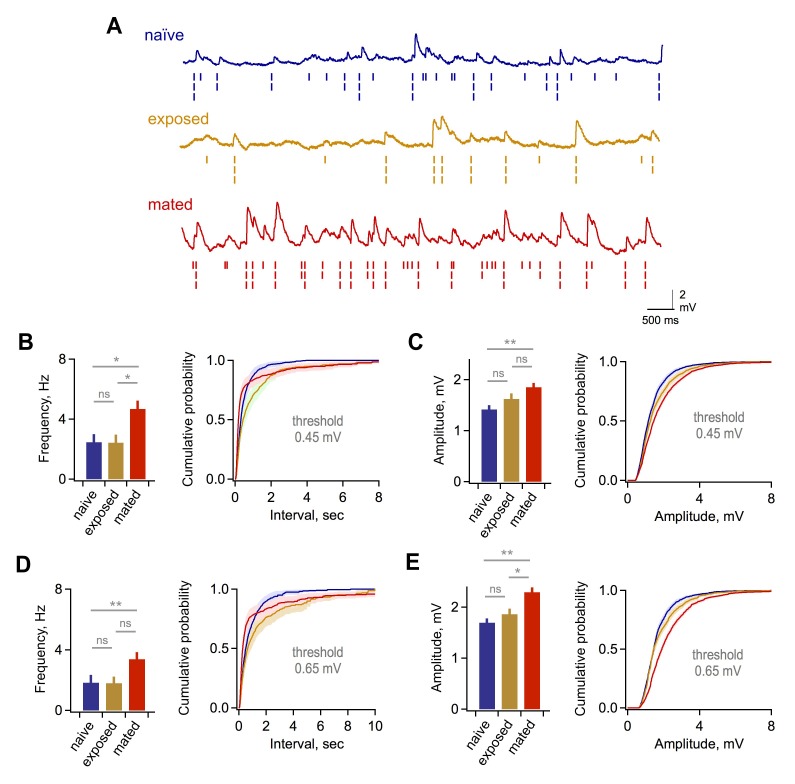
Synaptic effects in GCs are independent of event detection criteria.(A) Raw data traces with rasters showing synaptic events detected using thresholds of 0.25, 0.45, and 0.65 mV. (B) Mean frequency (left) and cumulative distribution of interevent interval (right) for excitatory synaptic input using a detection threshold of 0.45 mV. Mean frequency, 2.47 ± 0.53, 2.43 ± 0.53, and 4.69 ± 0.55 Hz; F = 5.93; Fc = 3.14; p=0.012 and 0.038 for mated vs exposed and naïve groups respectively. (C) Mean and cumulative distribution of EPSP amplitudes for the same criteria. Mean amplitudes, 1.42 ± 0.08, 1.62 ± 0.11, and 1.85 ± 0.08 mV for naïve, exposed, and mated groups respectively. F = 5.58; Fc = 3.14; p=0.0047 for mated vs. naïve groups. (D,E) Corresponding plots using a threshold of 0.65 mV. Mean frequency, 1.84 ± 0.51, 1.80 ± 0.42, and 3.38 ± 0.46 Hz; F = 3.89; Fc = 3.14; p=0.048 for mated vs naïve groups. Mean amplitude, 1.70 ± 0.08, 1.86 ± 0.11, and 2.29 ± 0.09 mV for naïve, exposed, and mated groups respectively. F = 10.52; Fc = 3.14; p=0.0021 and 0.0062 for mated vs. naïve and exposed groups respectively. *p<0.05; **p<0.005; all p values calculated using ANOVA with post-hoc Tukey test.